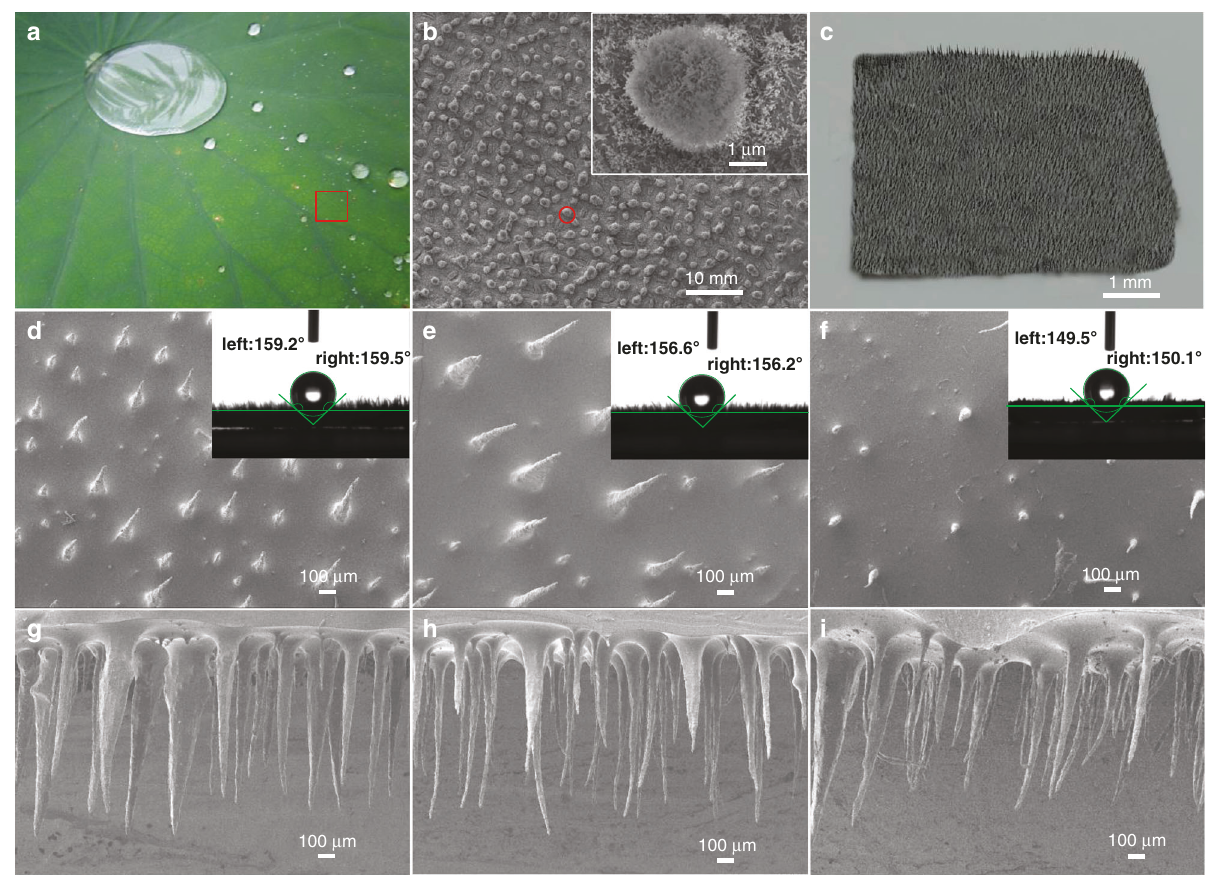
Fig. 2 Morphological characterization of lotus leaf and bionic cilia. a Prototype of lotus leaf. b SEM image of lotus leaf. The inset shows a papillary protrusion on the surface of lotus leaf. c The prepared physical sample of Pem-iCM. d – f Different aspect ratios of bionic cilia (Supplementary Table 1, aspect ratio (47, 25, 13) = Length (mm)/Diameter (mm)). The insets show the water contact angles of three samples. g – i Cross-sectional SEM images of bionic cilia with different aspect